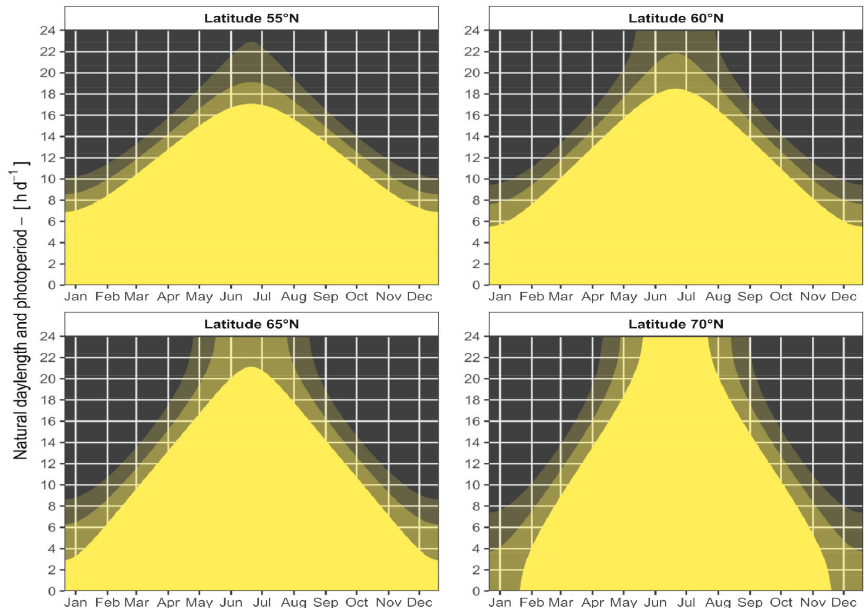
Figure 2. Natural daylength and photoperiod (h · d − 1 ) throughout the year in four northern latitudes (55 ◦ , 60 ◦ , 65 ◦ , and 70 ◦ ). The solid yellow region represents the daytime or period when the sun is above the horizon. The two increasing levels of transparency correspond to the civil twilight (0 ◦ to 6 ◦ below the horizon) and the nautical twilight (6 ◦ to 12 ◦ below the horizon)